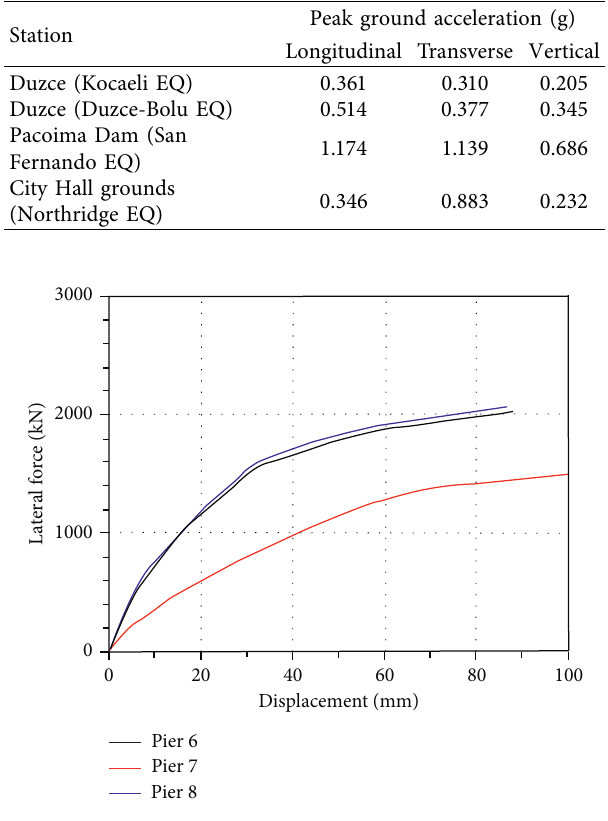
Figure 4: Static lateral force-displacement response of piers. Table 2: Static response